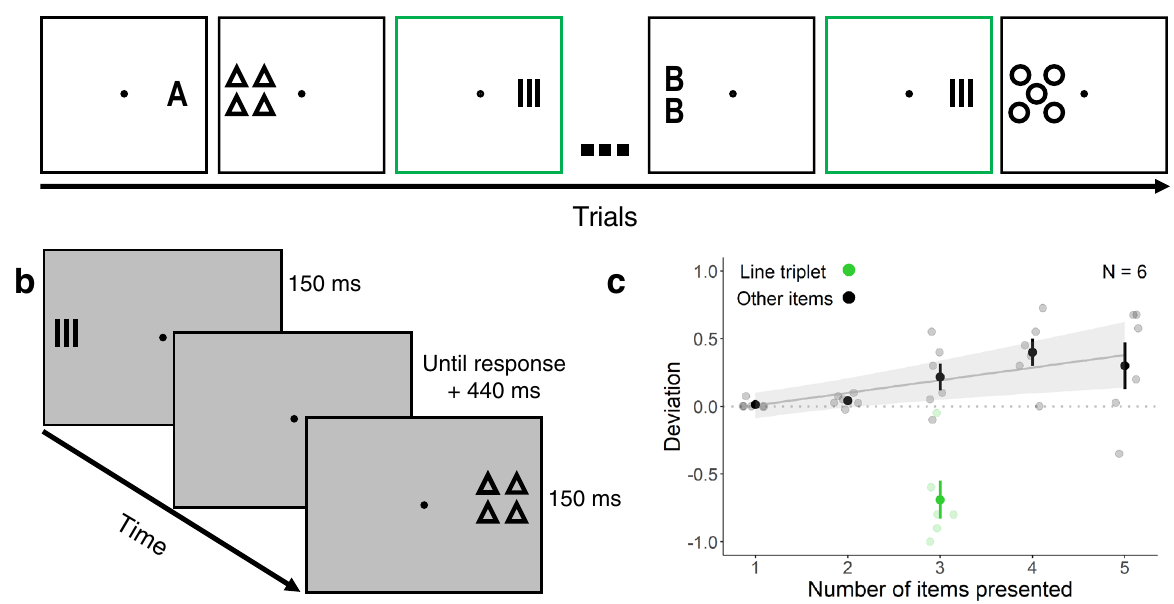
Figure 3. Illustration of a sequence of trials ( a ), schematic depiction of the experimental paradigm ( b ), and results of Experiment 3 ( c ). ( a ) The line triplet is shown with green frames (for illustration). ( b ) Observers were randomly presented with 1 to 5 items with different shapes to the left or right side of fixation. ( c ) Deviation scores are plotted as a function of the number of items presented. Black and green data points show mean deviation scores (± SEM ). Grey and light green data points show mean deviation scores for each individual observer. The grey line and shaded regions show the model fit and confidence intervals (± 1.96 * SEM